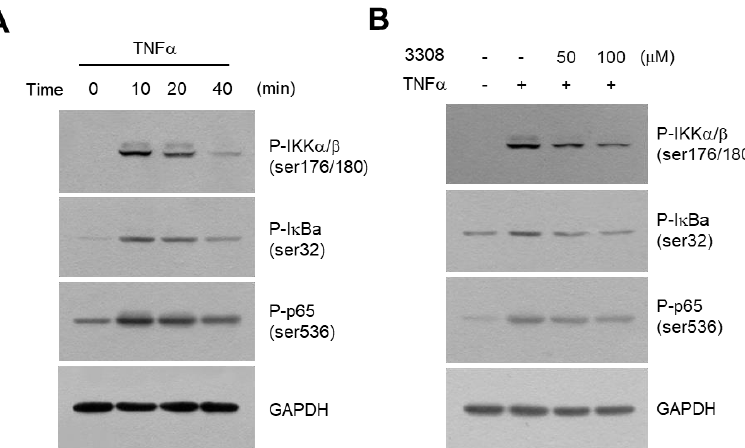
Figure 10. Effect of compound 5 on the inhibition of the IKK signaling pathway in HCT116 colon cancer cells. ( A ) HCT116 cells were starved with 0.5% fetal bovine serum for 24 h, followed by stimulation with 10 ng/mL TNFα for the indicated times. Whole-cell lysates were prepared, and Western blotting was performed using the phospho- specific antibody against IKKα/β (Ser176/180), IκBα (Ser32), and p65/RelA NF - κB (Ser536). Glyceraldehyde phosphate dehydrogenase (GAPDH) was used as an internal control. ( B ) HCT116 cells were starved with 0.5% FBS for 24 h, followed by pre-treatment with compound 5 (5 or 20 μM) 30 min before stimulation with 10 ng/mL TNFα. After 10 min, whole-cell lysates were prepared, and Western blotting was performed using the phospho- specific antibody against IKKα/β (Ser176/180), IκBα (Ser32), and p65/RelA NF - κB (Ser536). GAPDH was used as an internal control.